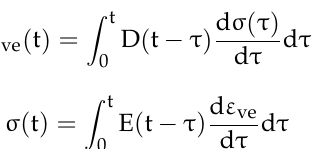
Figure 5. Schematic—typical creep-recovery strain components.